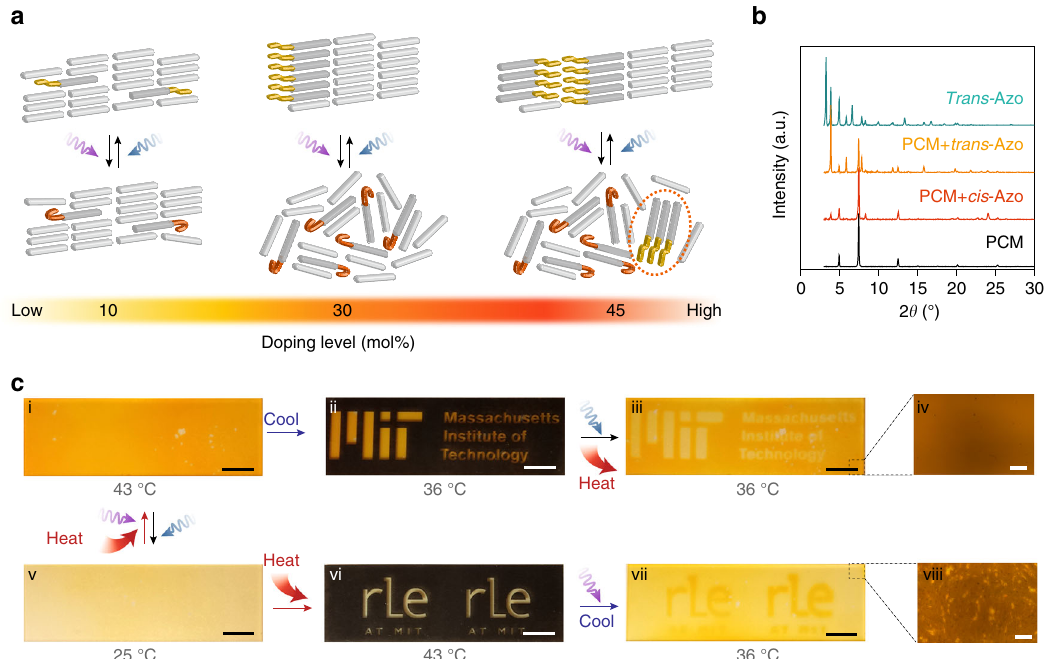
Fig. 3 Proposed mechanism and demonstration of the optical manipulation of composites. a Expected distribution and arrangement of azobenzene and phase-change materials (PCM) molecules at room temperature when dopants are uncharged and charged by ultraviolet (UV) illumination, at varied doping levels. b X-ray diffraction patterns of trans azobenzene dopant ( trans -Azo), PCM, and the composites with 30 mol% charged (PCM + cis -Azo) and uncharged dopants (PCM + trans -Azo), obtained at room temperature. c Demonstration of reversible charging and discharging of PCM composite fi lms (30 mol% doped), sandwiched between two glass slides. (i – iii) UV/thermally charged composite was cooled at 36 °C and illuminated with visible light selectively on the uncovered area (orange letters), while the rest of the fi lm was covered by a black mask under the isothermal condition. Scale bar is 10 mm. (v – vii) Uncharged composite was heated, and only the uncovered area (yellow letters) was irradiated with UV for 1 h. Then, the sample was cooled at 36 °C. Scale bar is 10 mm. Optical microscopic images of a charged part (iv, liquid) and discharged part (viii, crystalline solid) of composite fi lms. Scale